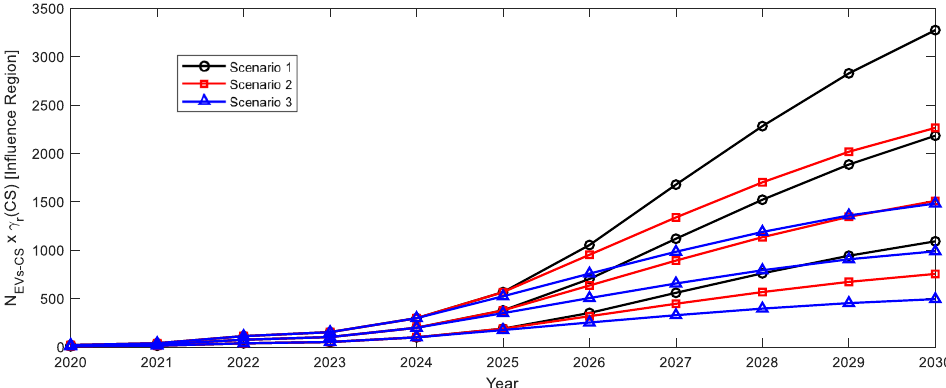
Figure 14. Estimation of EVs in the region of influence (considering public charging scenarios).